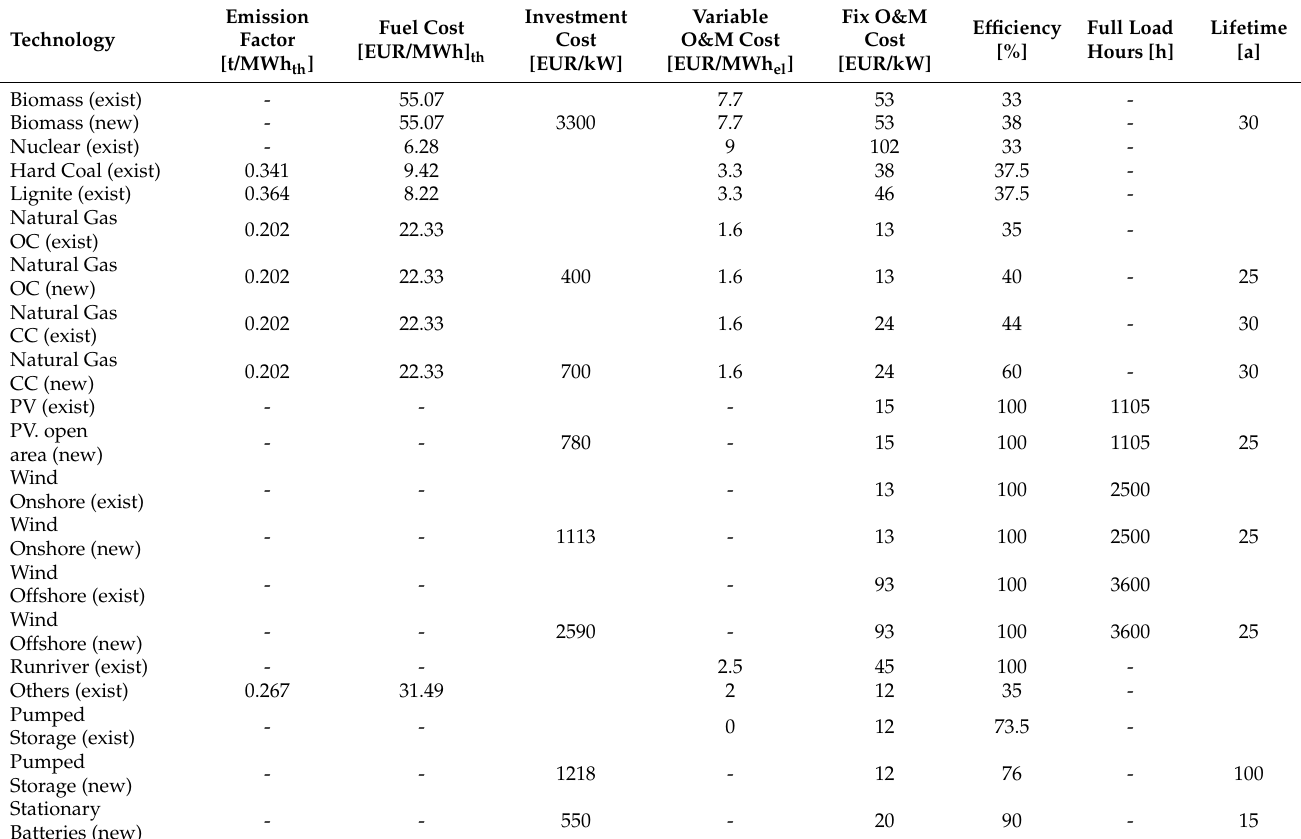
Table A1. Technical and economic assumption for generation technologies in CEM and